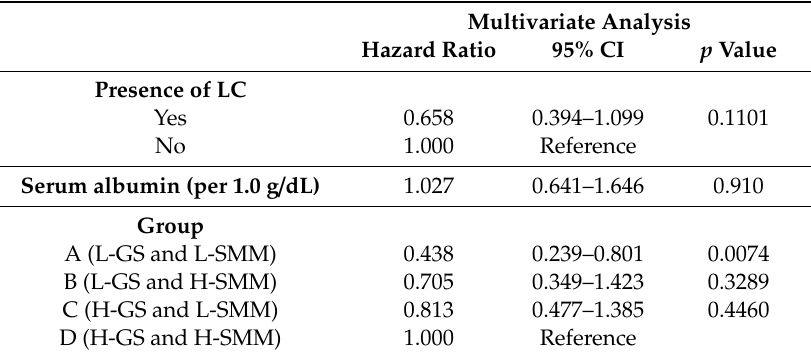
Table 4. Multivariate analyses of factors linked to BDI-II score ≥